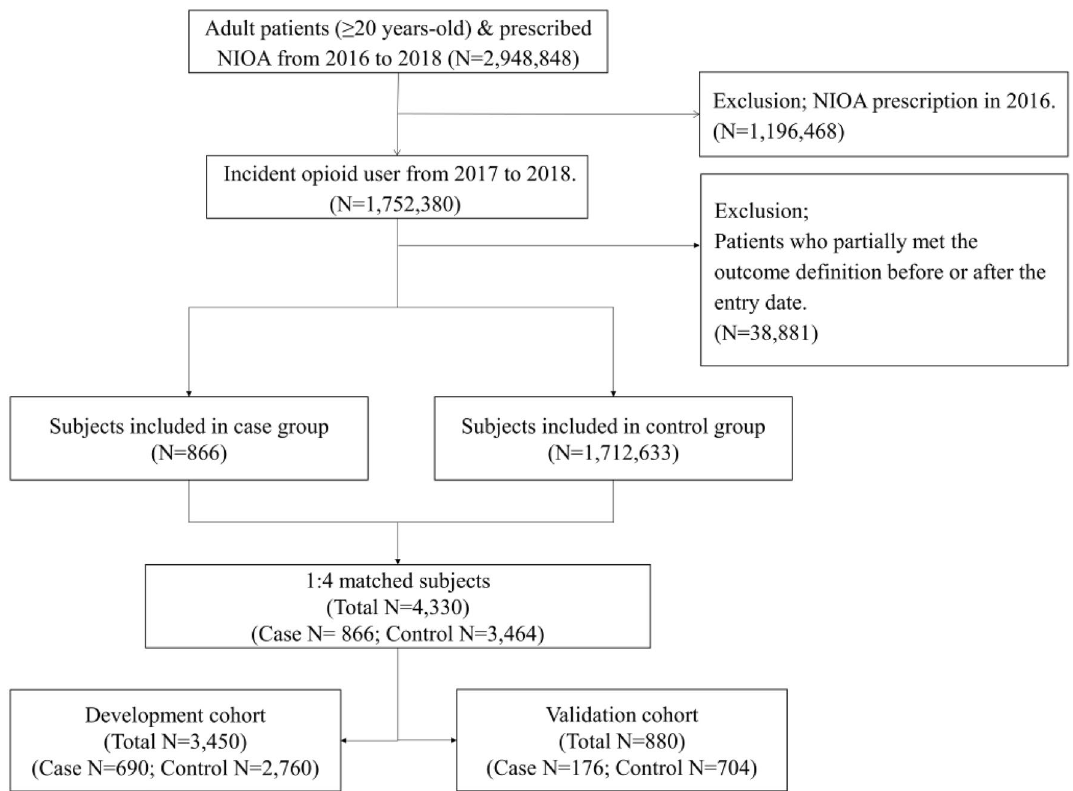
Figure 1. Patient-selection flow chart. NIOA non-injectable opioid